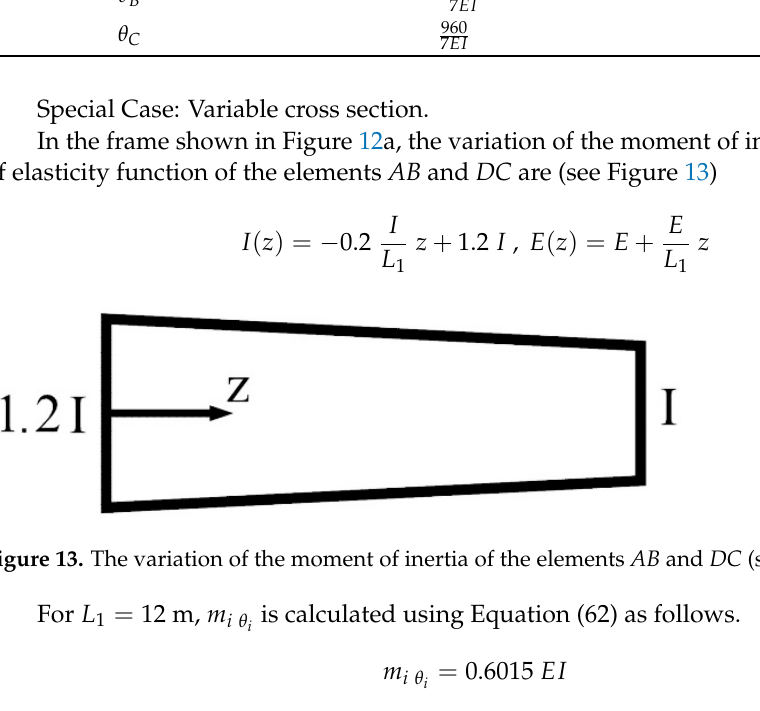
− 960 7 EI 960 7 EI